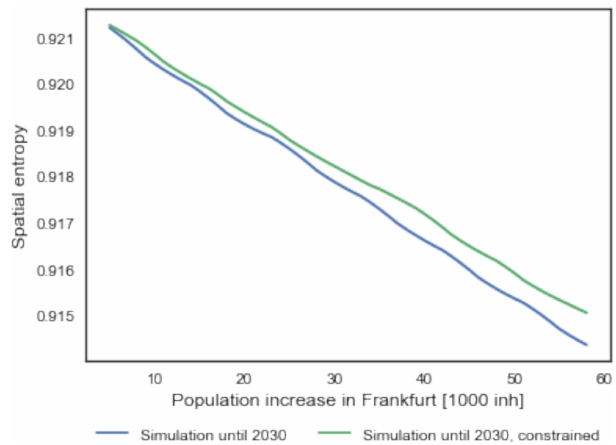
Figure 7. Changes in energy consumption per capita along the transformation of the urban form of Frankfurt. The probabilistic ap- proach creates some steps that punctually increase the energy con- sumption; nevertheless it doubles the decrease in energy consump- tion for transportation